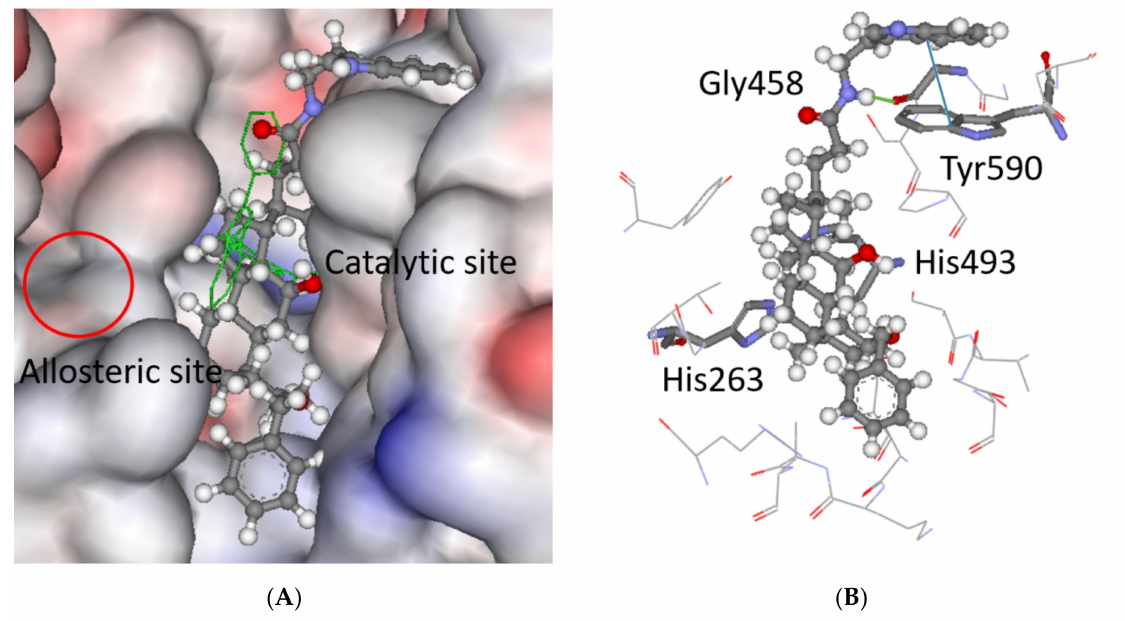
Figure 4. The docked pose of compound 5 in the catalytic site of TDP1 as predicted by the ChemScore scoring function. ( A ) The ligand is shown in the ball-and-stick format. The catalytic pocket is to the right-hand site, the co-crystallized ligand is depicted as green lines. The allosteric pocket is not predicted to be occupied (see circled area). The protein surface is rendered; blue depicts regions with a partial positive charge on the surface; red depicts regions with a partial negative charge and grey shows neutral areas. ( B ) The predicted configuration depicted as balls-and-sticks with hydrogen bonding to the backbone carbonyl of Gly458 (1.8 Å—green line) and π – π stacking between the indolyl rings in the ligand and Tyr590 (4.5 Å—blue line). These amino acid residues are shown as sticks as well as the catalytic His263 and His493. The adjacent amino acids (<5 Å), buttressing the ligand, are shown as lines. The hydrogens on the amino acids are not shown for